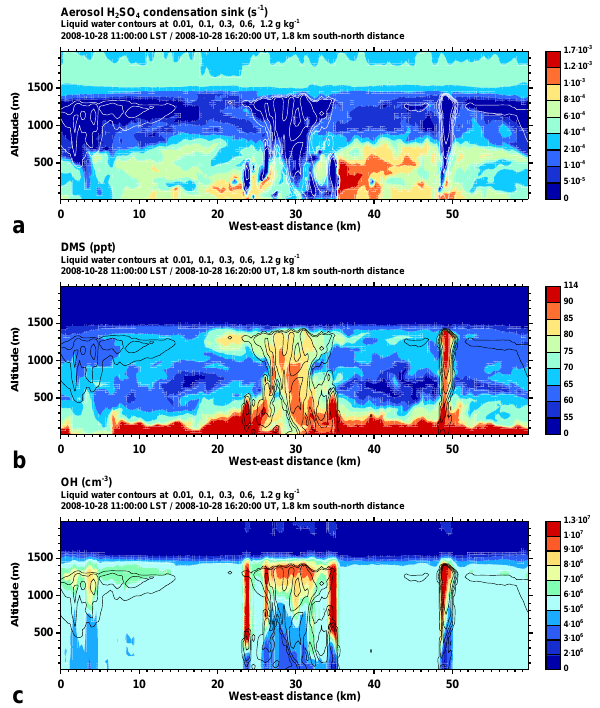
Fig. 5. Vertical slices through the domain of simulation S 0 at 28 October 2008 16:20UT. Contour lines denote liquid water (sum of cloud and rain water). (a) SO 2 forms from oxidation of DMS by OH in the upper boundary layer. Near the ocean surface SO 2 occurs in patches with mildly elevated levels, while its mixing ratios are de- pressed inside the cloudy updrafts due to uptake by liquid water and aqueous chemistry. (b) H 2 SO 4 forms from oxidation of SO 2 by OH and accumulates in the ultra-clean layer. (c) The elevated H 2 SO 4 concentrations initiate aerosol nucleation in a thin layer below the inversion and above or between cloud